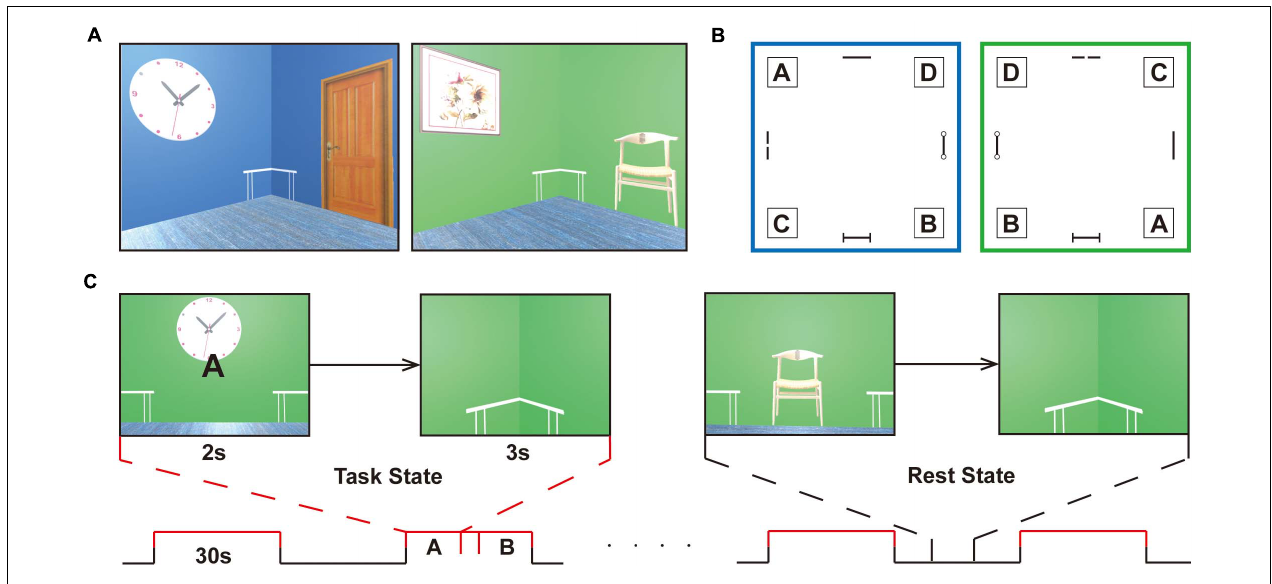
FIGURE 1 | Experimental design. (A) Navigation task is completed in two virtual reality rooms of different colors (i.e., green or blue) with four decorations on the wall (i.e., clock, panting, door, chair). (B) Schematic of the room layouts with the four target corners, labeled A, B, C, and D. A birch-colored table is placed in each corner of the room and is immaterial as a cue during navigation. The target positions are set under the tables, corresponding to the letters, A, B, C, and D. The two rooms are designed to increase the difficulty of the task. (C) The task proceeds in a block-design manner with a 30 s duration of each block. The task stage alternates with the resting stage in the course of 8 min. In the retrieval stage (task state), participants enter the room and face the wall, where a random letter for the navigation target is displayed for 2 s. When they arrive at the targets, the viewpoint transitions downward so that the identical floor texture occupied the entire field of view. Participants will be given a feedback (a check mark or a cross) after navigation in the learning and testing phase, but not in the scanning stage. After a 3 s countdown, a new letter was given that was to be followed. In the non-retrieval stage (rest state), no letter prompts and no movements were made, and random perspectives were displayed. The subjects were requested to press buttons at the same frequency as the task and watch the screen to ensure visual matching. The entire task is only used to distinguish between navigational (task) and non-navigational (rest) states.